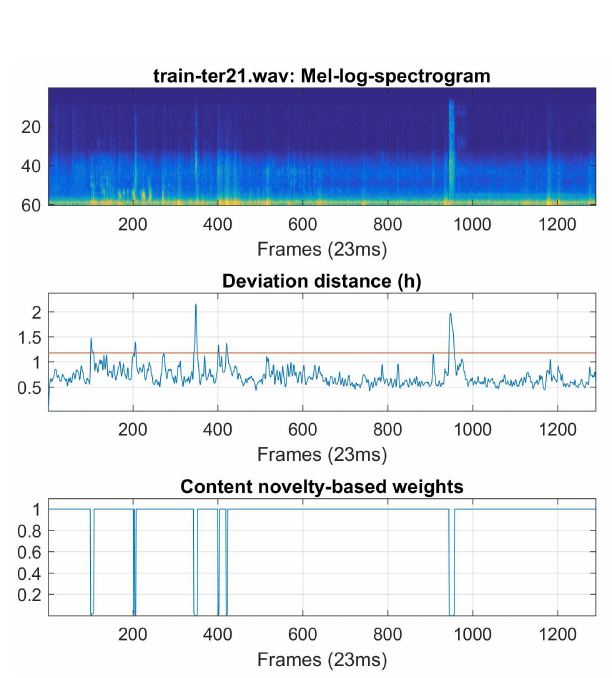
Figure 6. Example of acoustic texture enhancing weights